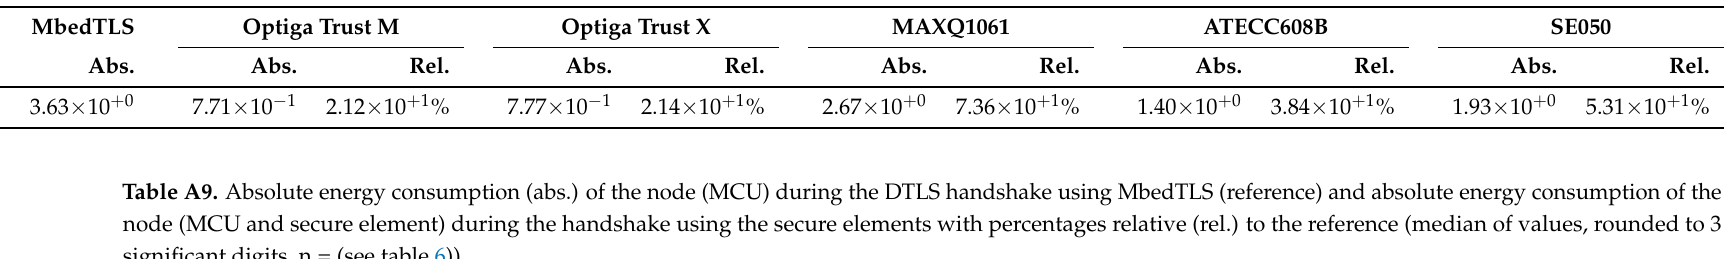
Table A8. Absolute execution time (abs.) of the node (MCU) during the DTLS handshake using MbedTLS (reference) and absolute execution time of the node (MCU and secure element) during the handshake using the secure elements with percentages relative (rel.) to the reference (median of values, rounded to 3 significant digits, n = (see table 6)).